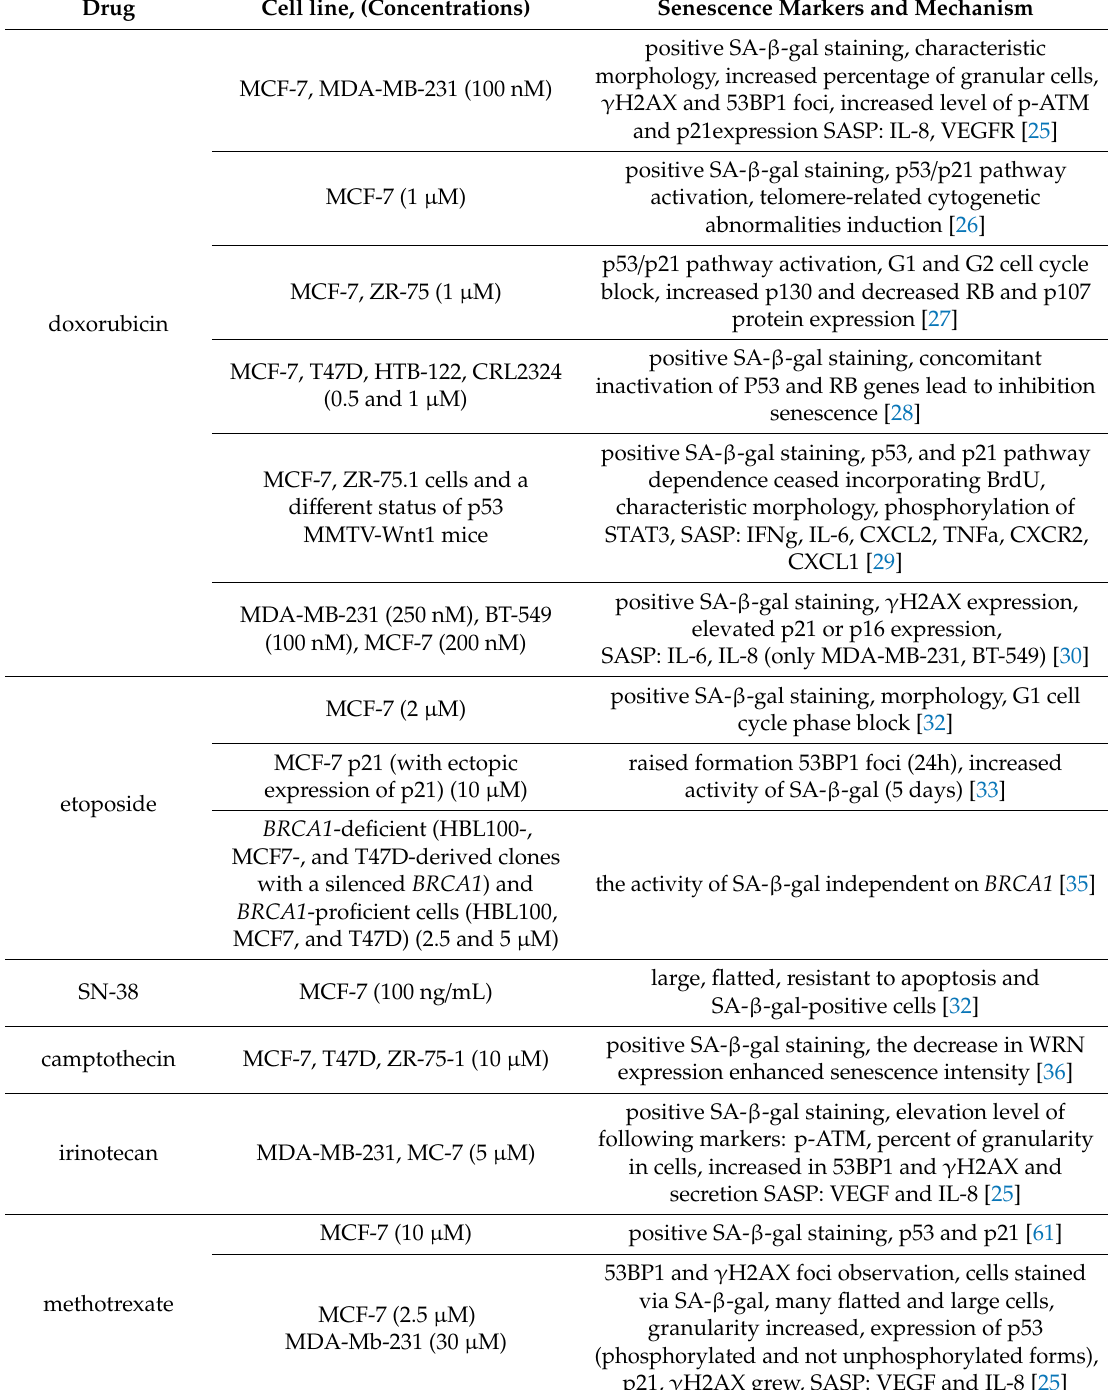
Table 3. Senescence induction via standard breast cancer